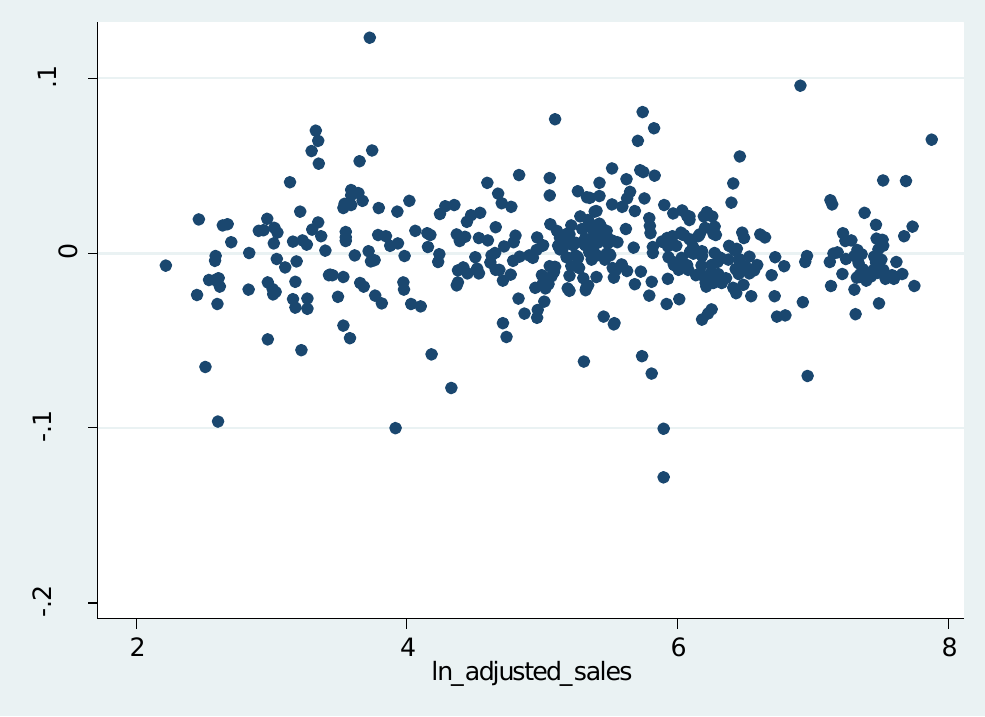
Figure 1. Residual vs SIZE